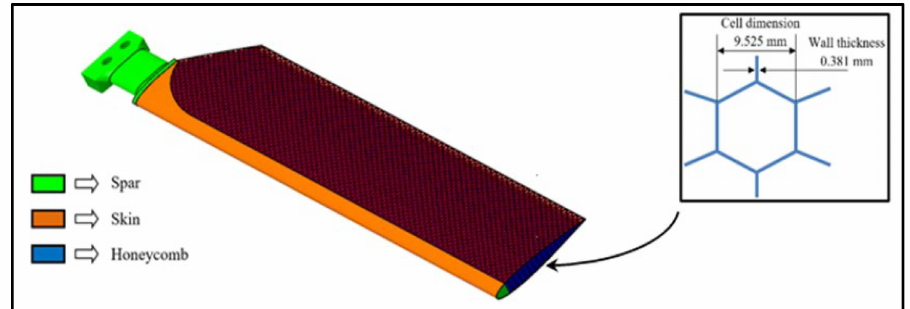
Figure 1. Main components of the composite tail rotor blade model.